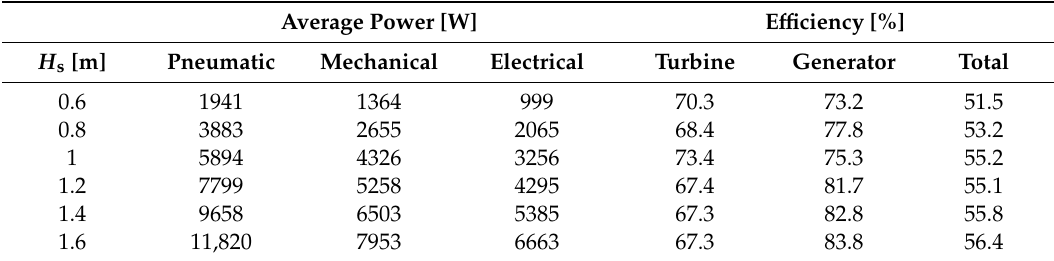
Table 4. Powers and e ffi ciencies obtained considering an Impulse turbine, with MPPT control; K adjust = 1.